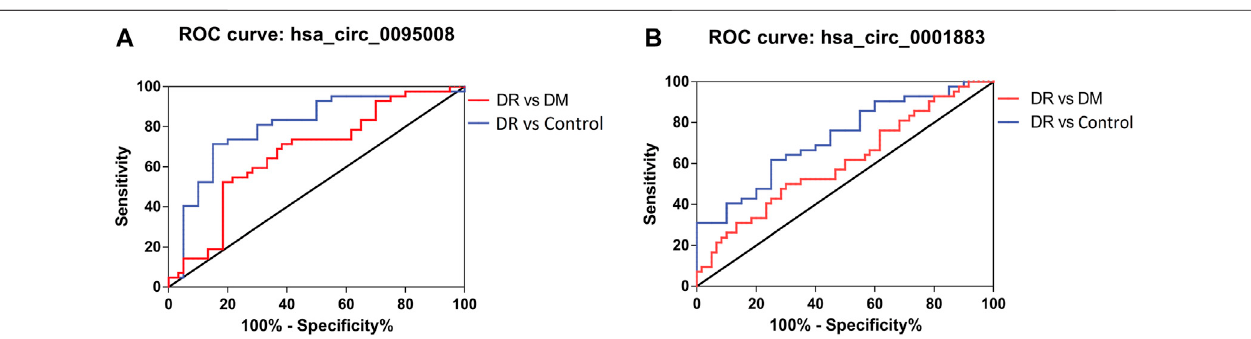
FIGURE5| ROCanalysisofhsa_circ_0095008 and hsa_circ_0001883 inDRsamples.Diagnosticvalueof (A) hsacirc0095008 and (B) hsacirc0001883 forDR. BluelinesrepresentROCcurvesofcircRNAsfordistinguishingDRpatientsfromhealthycontrols,whileredlinesrepresentROCcurvesofcircRNAsfordistinguishingDR patients from DM patients without DR.